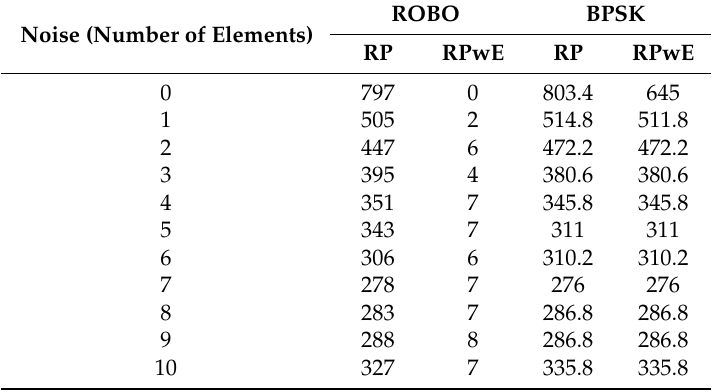
Table 7. ROBO and BPSK Modulations (Ratio of received packets according to noise inserted, from Tx to